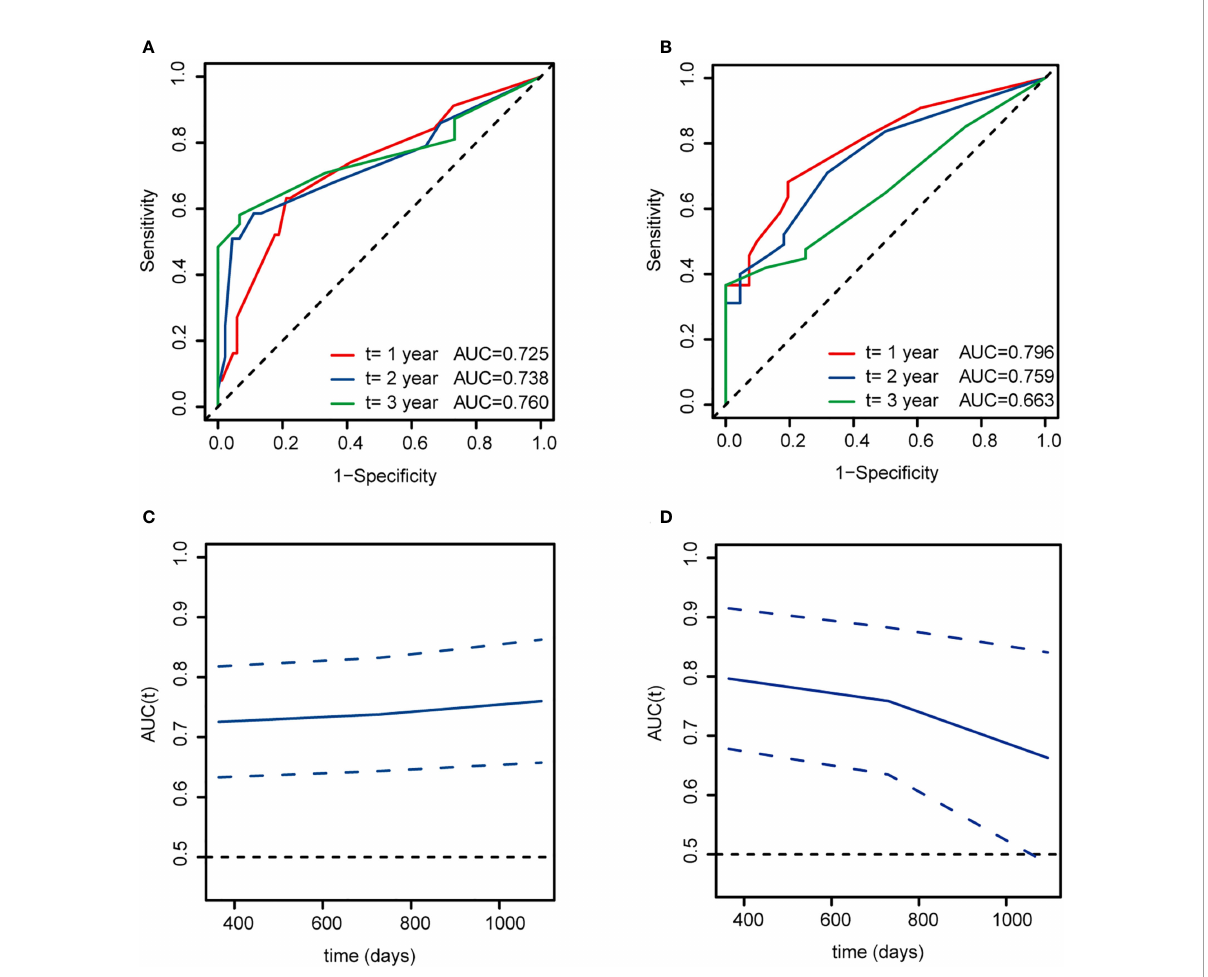
FIGURE 5 Time-dependent ROC curves for overall survival at 1, 2, and 3 years based on this model of ALL patients. (A, C) The training cohort. (B, D) The validation cohort. AUC, area under